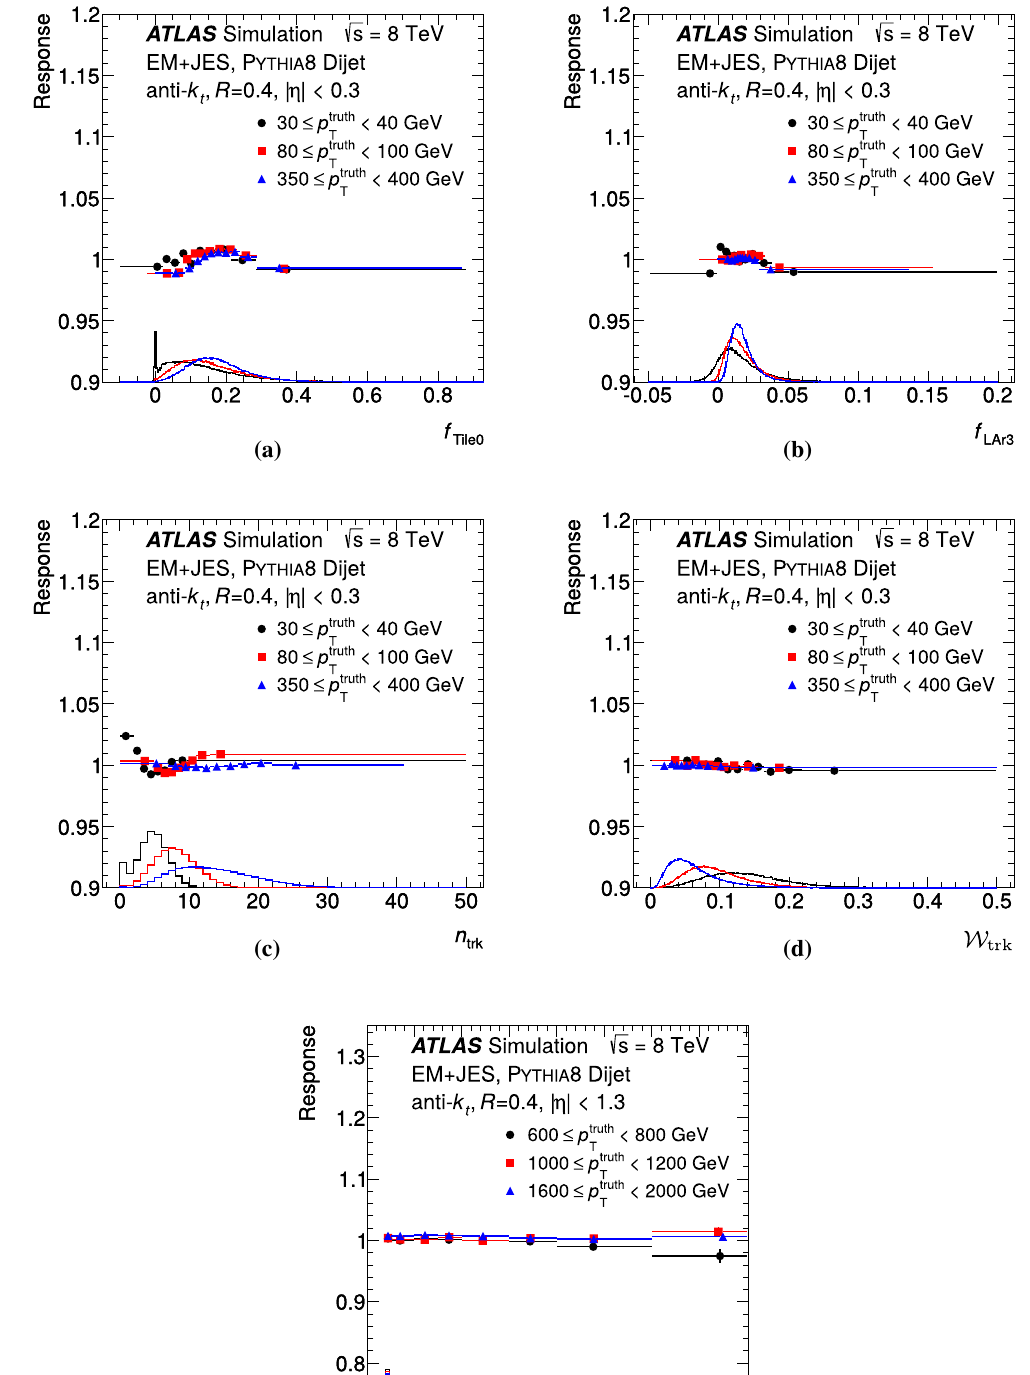
Fig. 9 Jet p T response as a function of f Tile0 , f LAr3 , n trk , W trk and N segments for jets with | η det | < 0 . 3 ( | η det | < 1 . 3 for N segments ) in dif- ranges. All jets are reconstructed with anti- k t R = 0 . 4 and ferent p truth T calibrated with the EM+JES scheme including global sequential cor-